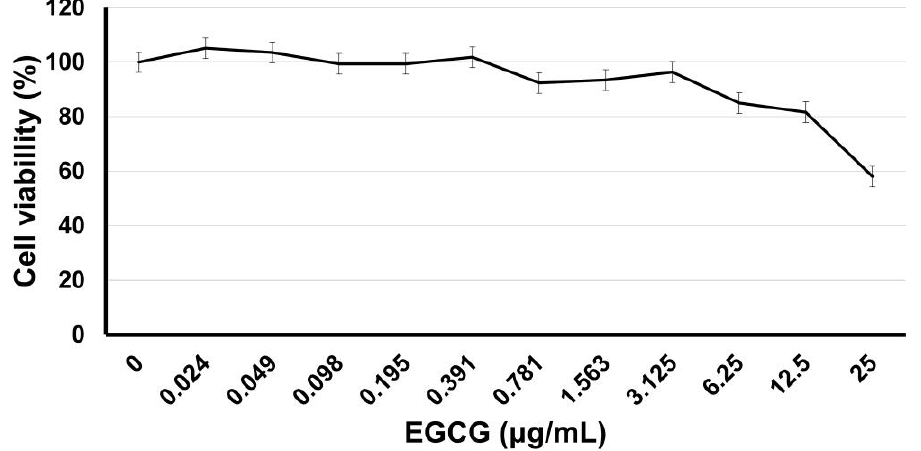
Figure 3. EGCG dose response in culture with hDPSCs. Near confluent hDPSCs (90% confluence, 4 PDL) were incubated for 24 h with EGCG at different concentrations from 0 to 25 µg/mL. After incubation, the relative viable cell number was determined by MTT assay. Each value represents the Mean ± SD of triplicate assays ( n = 9), 570 nm absorbances (0.247; 0.527). EGCG = (-)- Epigallocatechin - Gallate ; hDPSCs = human dental pulp stem cells; PDL = population doubling level; MTT = 3-[4,5-dimethylthiazol-2yl]-2,5-diphenyltetrazolium bromide; SD = standard